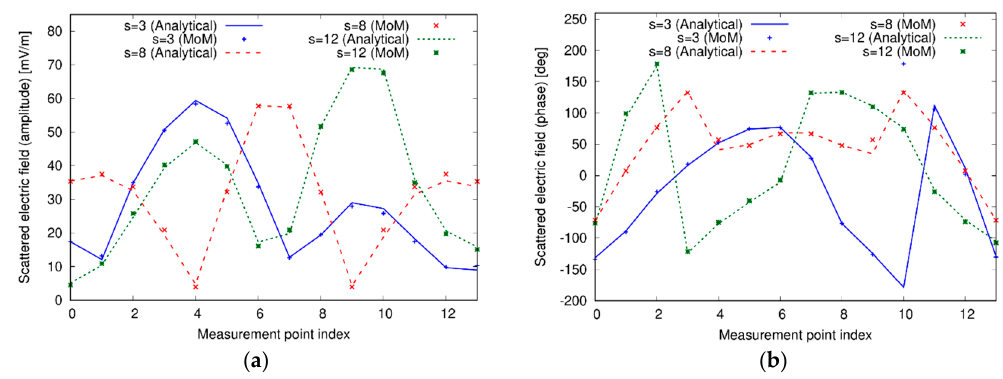
Figure 4. ( a ) Amplitude and ( b ) phase of the scattered fields in some of the considered view computed by the analytical forward solver based on the CWA and by the integral equation formulation used in the inverse scattering procedure. Two separate dielectric cylinders.